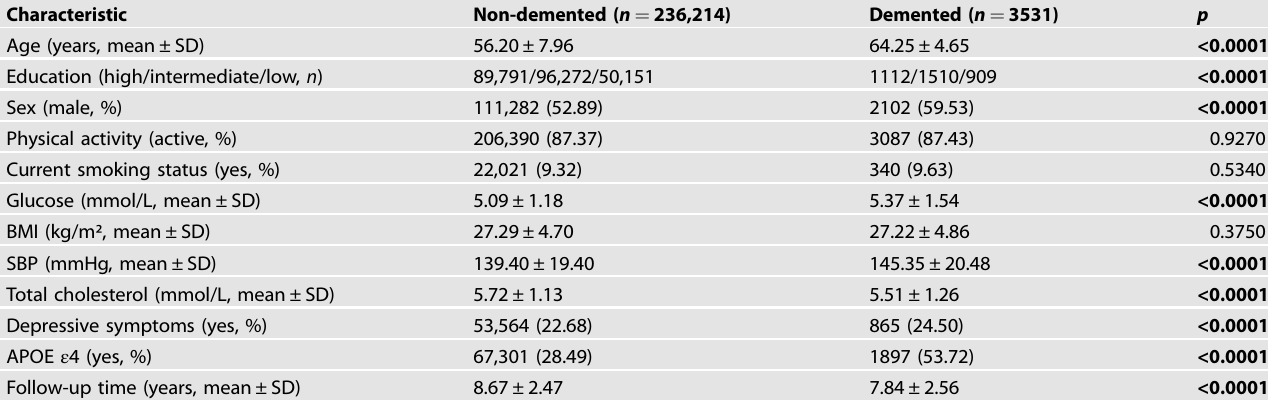
Abbreviations: BMI body mass index, AD alzheimer disease, SBP systolic blood pressure, DBP diastolic blood pressure, APOE apolipoprotein E. p values that are statistically signi fi cant are shown in